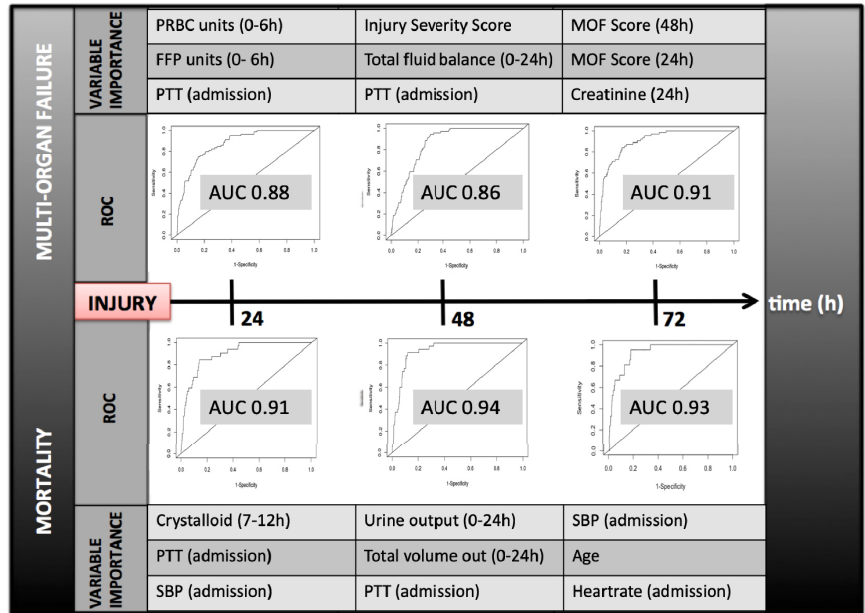
Fig 3. Variable importance by random forest for multi-organ failure and death at 24, 48, and 72 hours after injury. For each timepoint and outcome of interest the top three variables driving prediction are reported. h, hours after presentation; PRBC, packed red blood cells transfused within the first 6 hours; FFP, fresh frozen plasma transfused within the first 6 hours; MOF, multi-organ failure; PPT, partial thromboplastin time ROC, receiver operating characteristic curve, AUC, Area Under the Curve; SBP, Systolic blood